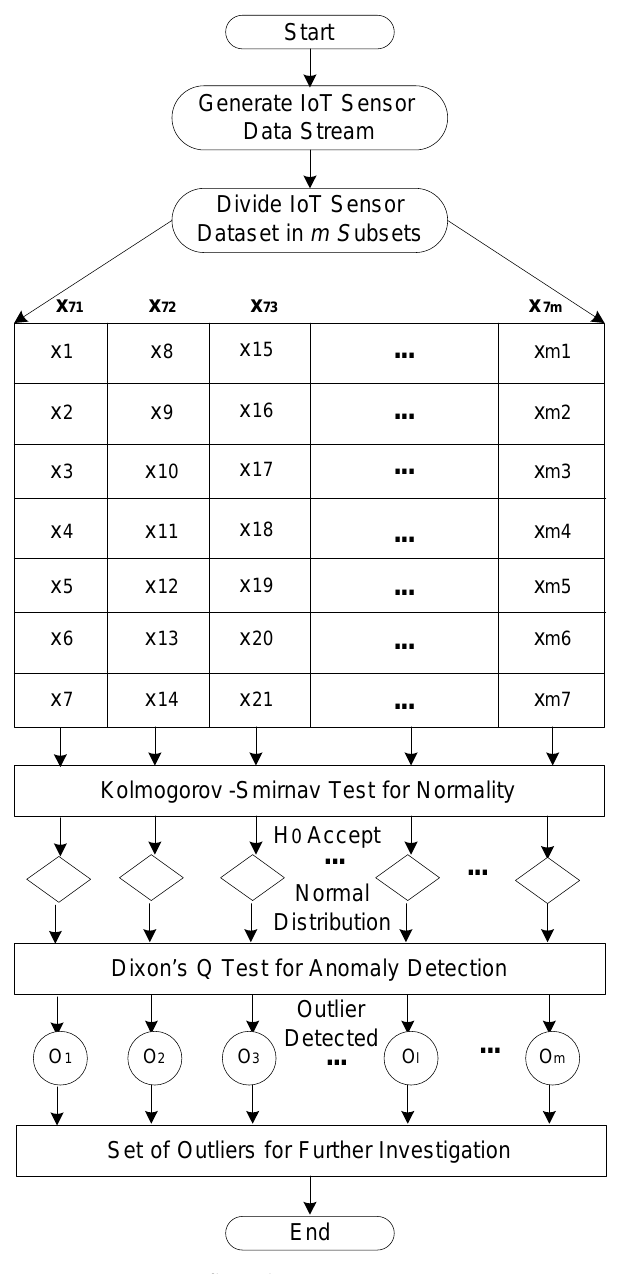
Figure 1. IoTDixon flow